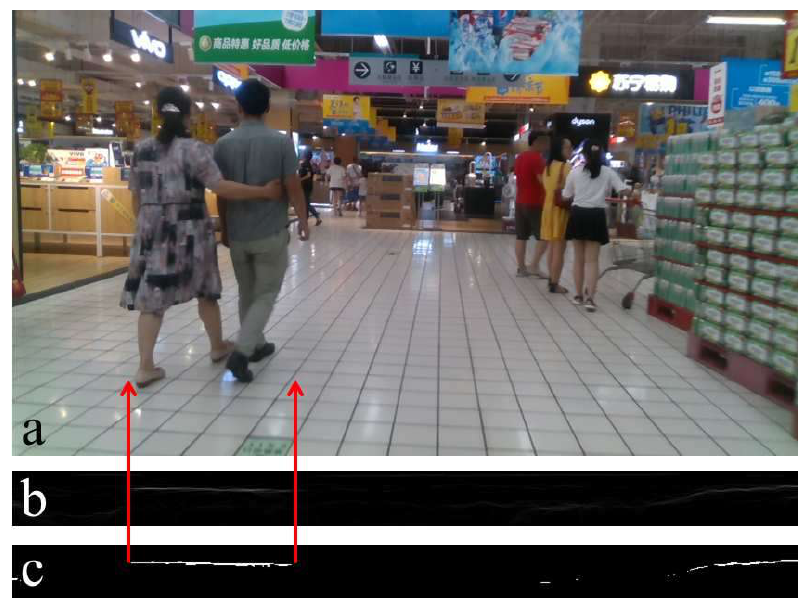
Figure 4. Obstacle’s width estimation from u-depth map. ( a ) Snapshot from OpenLORIS-Scene market data sequence [29]. ( b ) Corresponding u-depth map. ( c ) Corresponding thresholded u-depth map after closing operation.